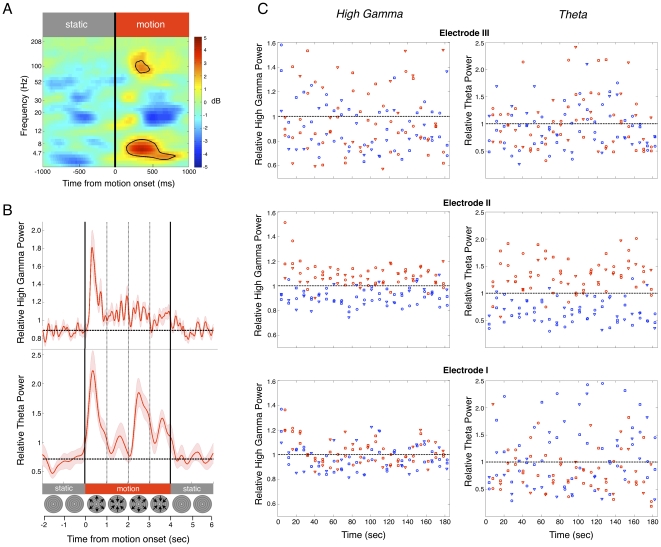
Electrophysiological response to the same motion stimuli as during fMRI.(A) Power spectrogram from electrode II in subject B during one representative run. Electrode II was the only electrode overlying the area of significantly increased BOLD activation during the motion stimulus (see Figure 1B). This electrode shows significantly increased power (denoted in decibels, dB) in the high-gamma and theta bands during motion compared to static (yellow-red). The significance threshold is FDR-corrected (q = 0.1, p<0.02). For presentation purposes, the spectrogram is smoothed over 3 frequency bands and 230 ms. (B) Temporal profiles of the relative power for high-gamma and theta bands in the same electrode during the same run. The power of high-gamma and theta band activity was normalized by the mean power (y = 1) within that band and across the run. The power in each band was scaled by these means. Vertical solid lines indicate transitions between static and motion, and vertical dotted lines indicated transitions between outward and inward motion of the stimulus. Horizontal dashed lines indicate the mean relative power during the static condition. The shading on the time courses indicates the standard error of the relative power. (C) The increase of high-gamma and theta power during the motion stimulus is consistent across individual trials and is selective to electrode II. Each red marker denotes the mean relative power across a single four-second trial of motion, while each blue marker denotes the mean relative power across a single four-second trial of static, for electrode II (middle row) and two neighboring electrodes (top and bottom rows, see Figure 1 for precise locations), across the duration of each run of the experiment. Different shapes (circles, squares, triangles) denote different runs of the experiment. Note that electrode I was near, but not overlapping with, the area of significantly increased BOLD activation to motion.